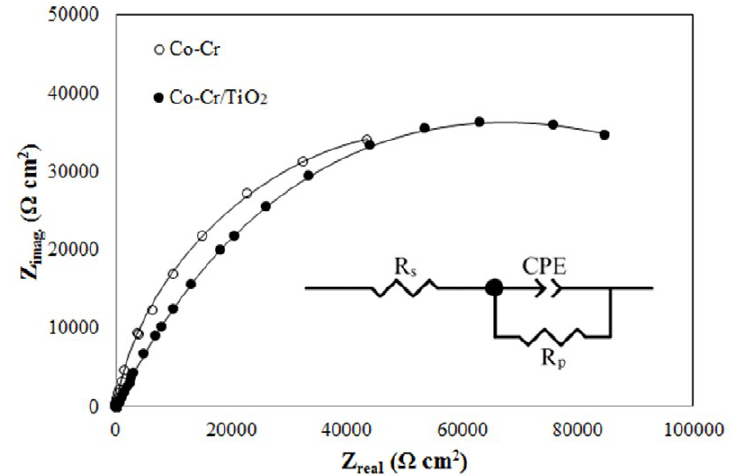
Fig. 5. Nyquist plots of Co-Cr and Co-Cr/TiO 2 and the equivalent circuit used to fit the experimental data.